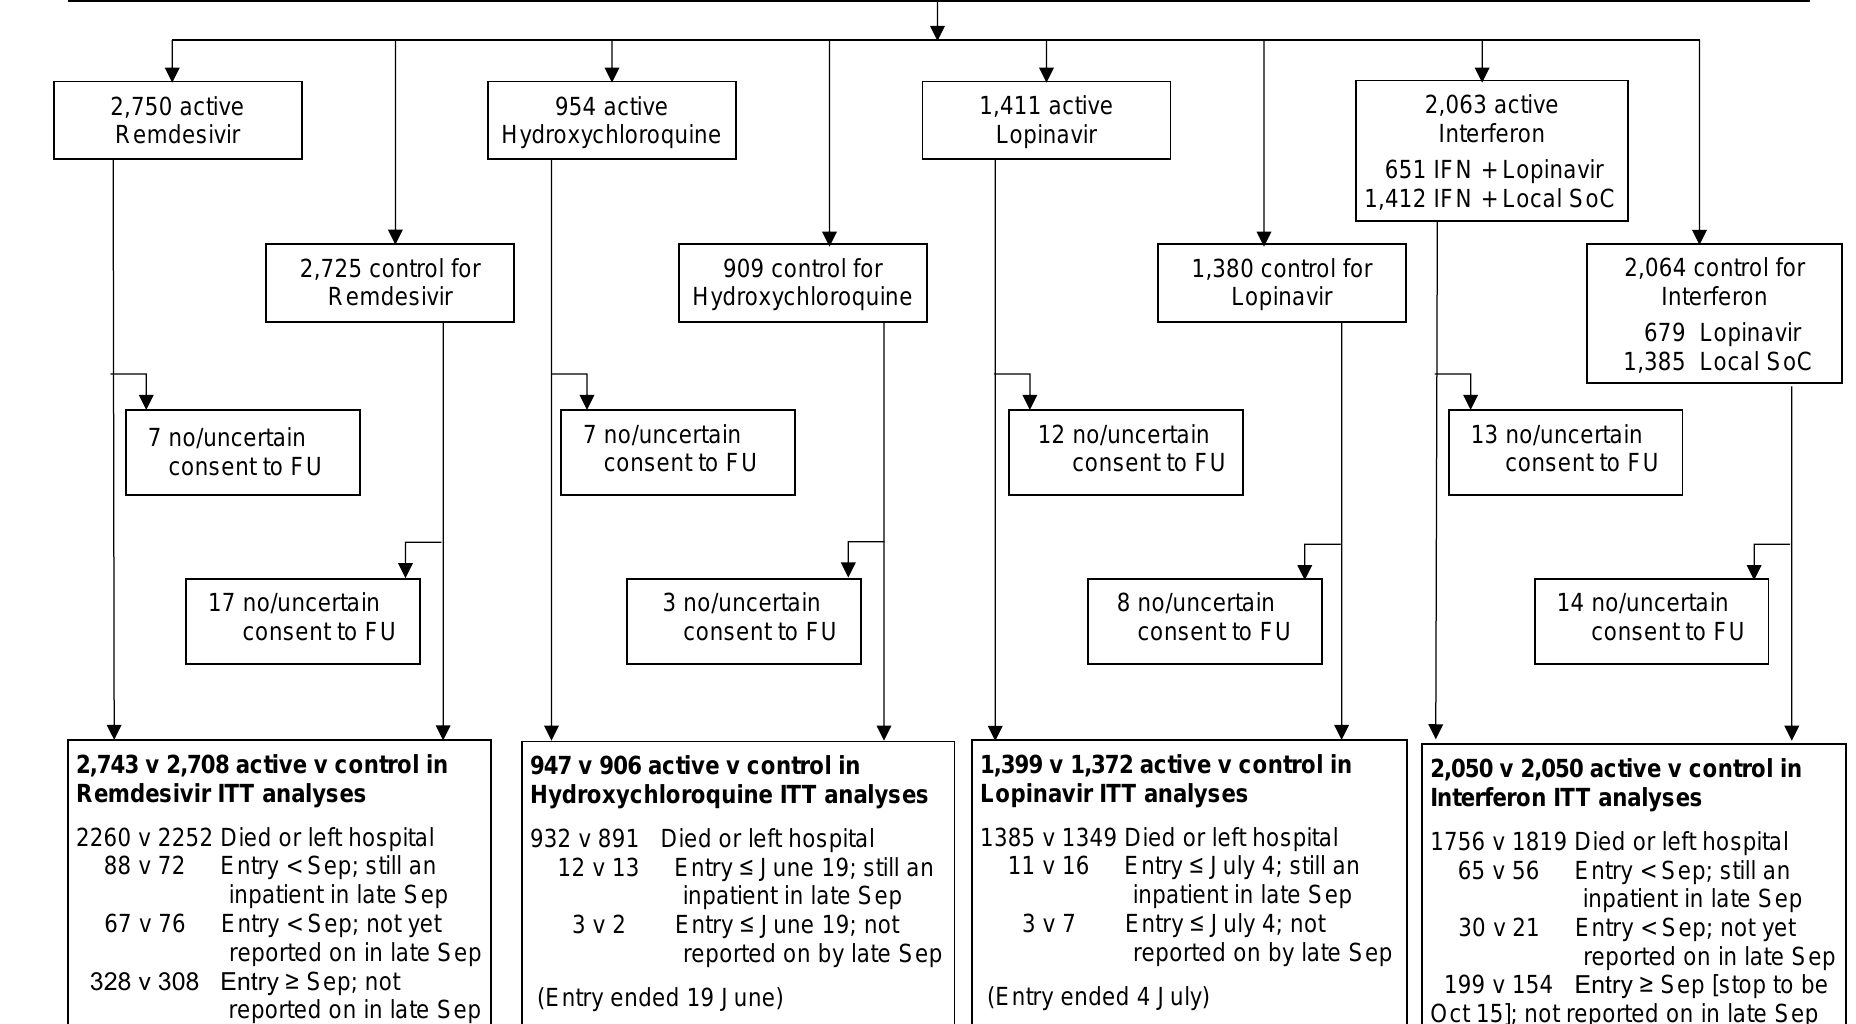
Figure 1. WHO Solidarity Trial – information to October 4, 2020 on entry, follow-up (FU) and intent-to-treat (ITT) analyses After asking which treatments were locally available, random allocation (with equal probability) was between local standard of care (SoC) and the available treatments. After excluding 64/11,330 (0.6%) with no/uncertain consent to follow-up, 11,266 remain in the ITT analyses. Each pairwise ITT analysis is between a particular treatment and its controls, ie, those who could have been allocated it but were concurrently allocated the same management without it. There is partial overlap between the 4 control